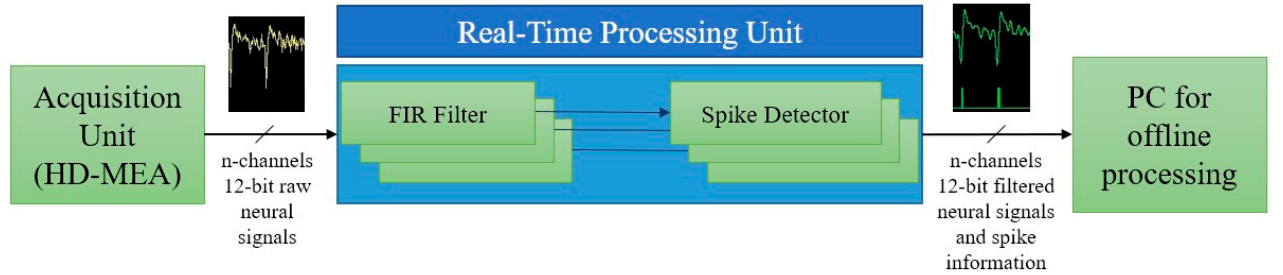
Figure 1. Block diagram of the processing system.